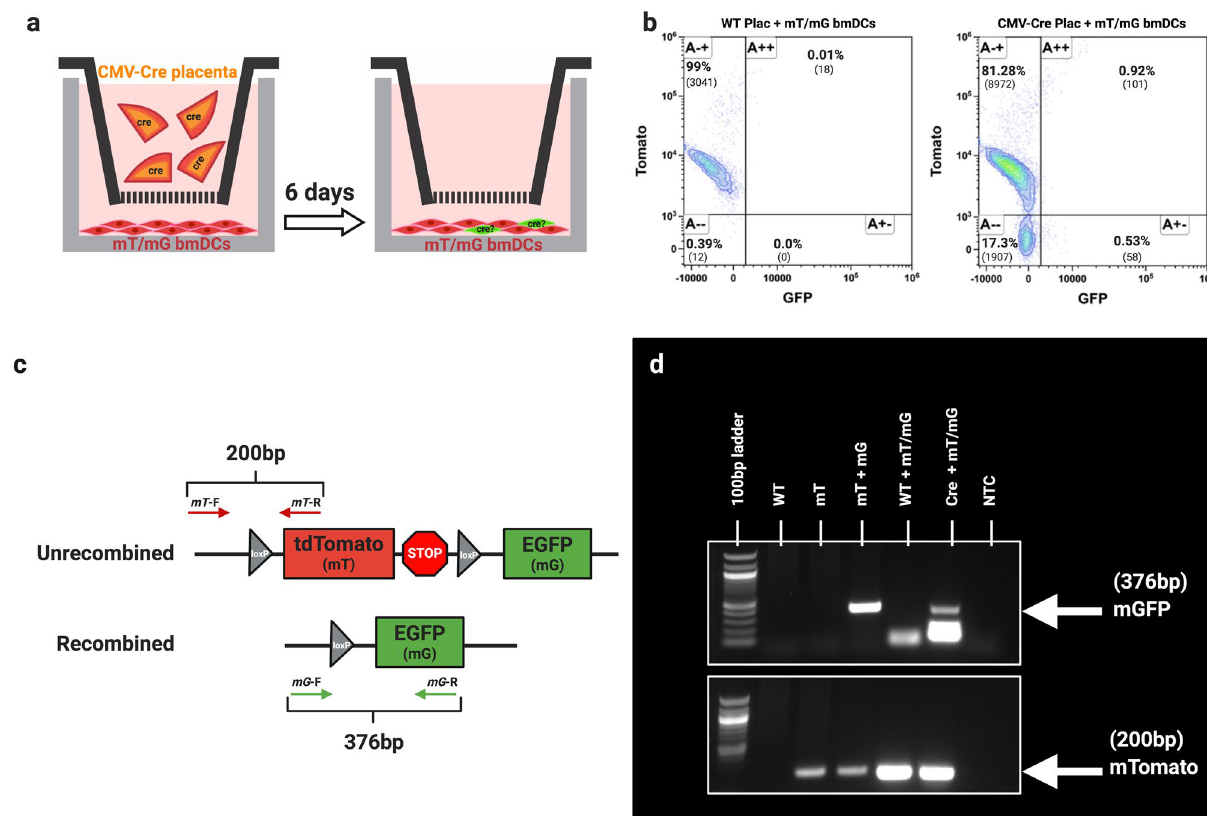
Figure 7. In Vitro Transfer of Placental Cre to Recipient Reporter Cells. ( a ) mT/mG BMDCs were cultured with (colorless) GD14.5 CMV-Cre placentas for 24 h and cultured for an additional 5 days. ( b ) Representative flow cytometry plots of mT/mG BMDCs cocultured with WT (left) or CMV-Cre (right) placentas; n = 1. ( c ) Schematic diagram of forward (mT-F/mG-F) and reverse (mT-R/mG-R) primers for identification of unrecombined mTomato and recombined mGFP. PCR amplification of genomic DNA with these primers results in PCR products of 376 bp for non-recombined cells and 200 bp for recombined cells. ( d ) Genotyping electrophoresis gel of mGFP (top) and mTomato (bottom) loci from genomic DNA. WT: tail DNA from a wild type mouse; mT: tail DNA from an mTmG mouse in the absence of Cre; mT + mG: tail DNA from a fully mTmG mouse; WT plac + mT/mG: DNA from dendritic cells cocultured with WT placenta; CMV-Cre plac + mT/mG BMDC: DNA from dendritic cells cocultured with CMV-Cre placenta; NTC, no template control. Representative gel image; n =